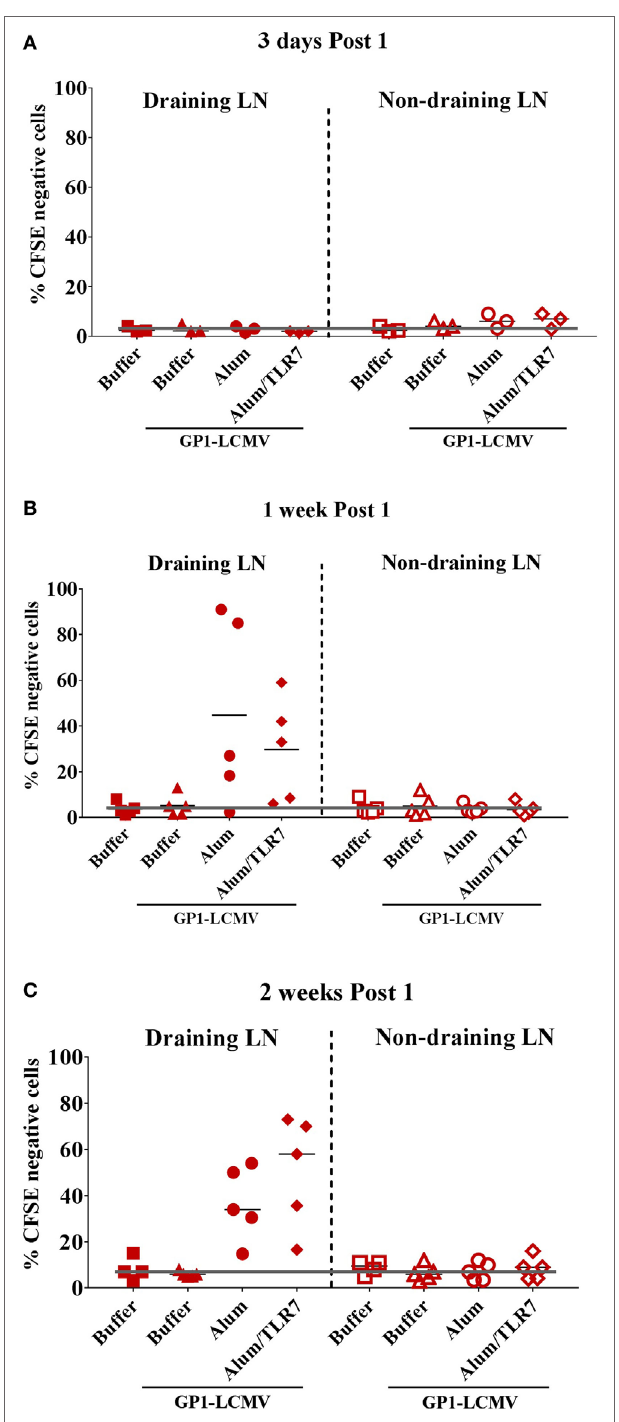
FigUre 1 | Proliferated antigen-specific B cells are detected only within draining lymph nodes (LNs), 1 week and 2 weeks post immunization with adjuvanted antigen. Mice adoptively transferred with CFSE-labeled glycoprotein 1 of lymphocytic choriomeningitis virus (GP1-LCMV)-specific naïve B cells were immunized intramuscularly in one leg with the cognate antigen alone or formulated with Alum or Alum/toll-like receptor (TLR)7. Mice treated with formulation buffer alone were used as negative control. Immunized mice were sacrificed 3 days, 1 week and 2 weeks after the treatment. Draining LNs and contralateral non-draining LNs were collected to be analyzed by flow cytometry to identify proliferated (CFSE low/negative ) and non-proliferated (CFSE positive ) antigen-specific B cells, according to the gating strategy reported in Figure S1 in Supplementary Material. The graphs show the percentage of CFSE low/negative proliferated antigen-specific B cells within draining (filled symbols) and non-draining (empty symbols) LNs 3 days (a) , 1 week (B) , and 2 weeks (c) after the immunization. Each symbol represents data from a single experiment. Results from five independent experiments are reported. The black orizonal lines represent the average percentage of proliferated cells in the five independent experiments, per each type of treatment. The gray line sets the threshold of proliferation based on the mice treated with formulation buffer alone in non-draining LN at each time